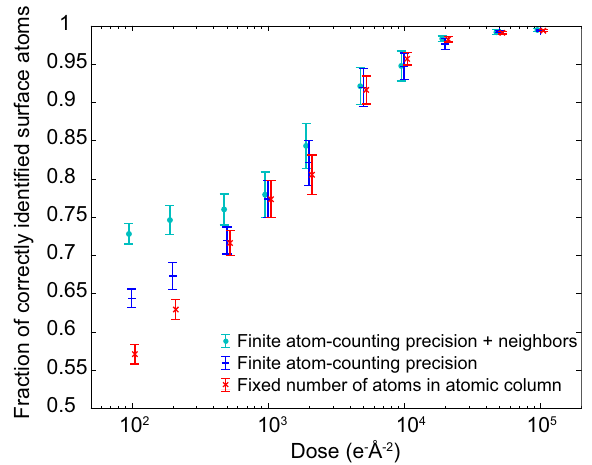
Fig. 3 Quanti fi cation evaluation of the reconstructed 3D models. Fraction of the surface atoms that are correctly reconstructed in 3D when including the fi nite atom-counting precision and neighbor- mass relations as prior knowledge. As a reference, the results when using a fi xed number of atoms in a column are also displayed. The error bars indicate 95% con fi dence